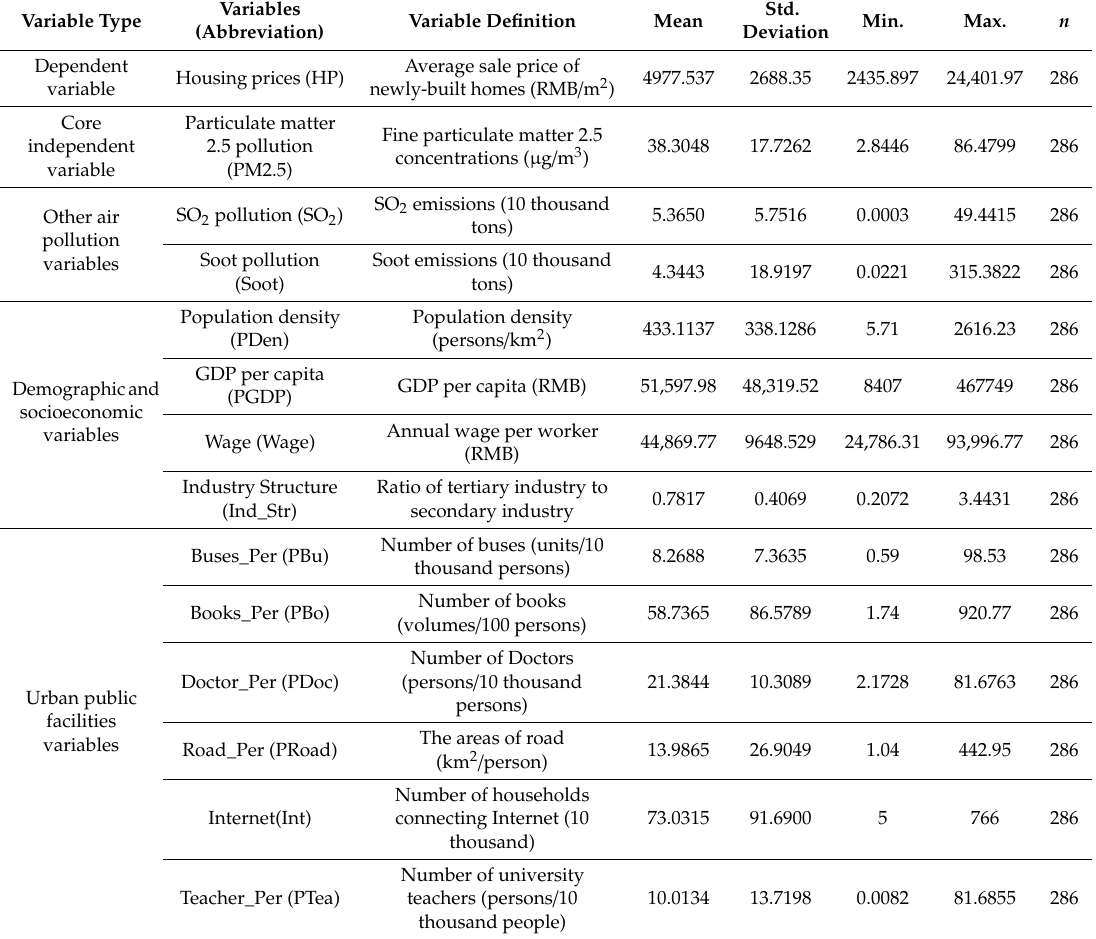
Table 1. Variable descriptions and descriptive statistics for